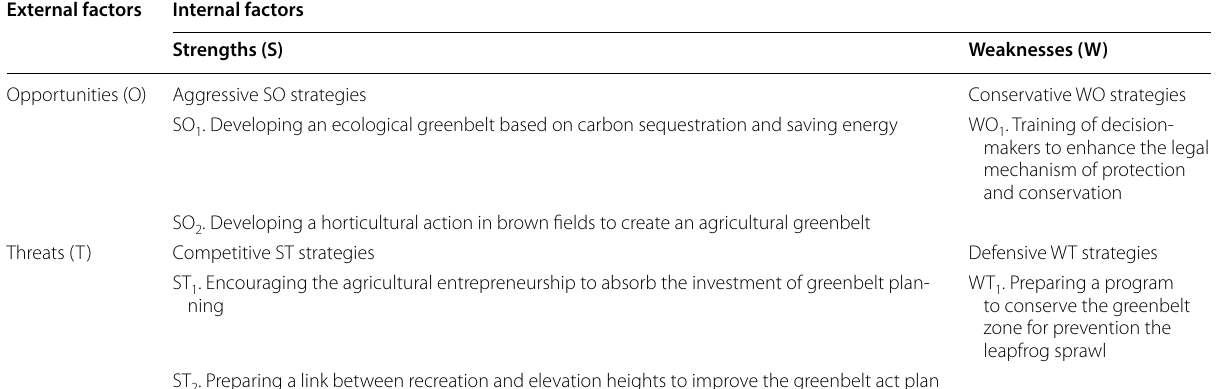
Table 10 Developing key strategies for greenbelt planning by SWOT analysis